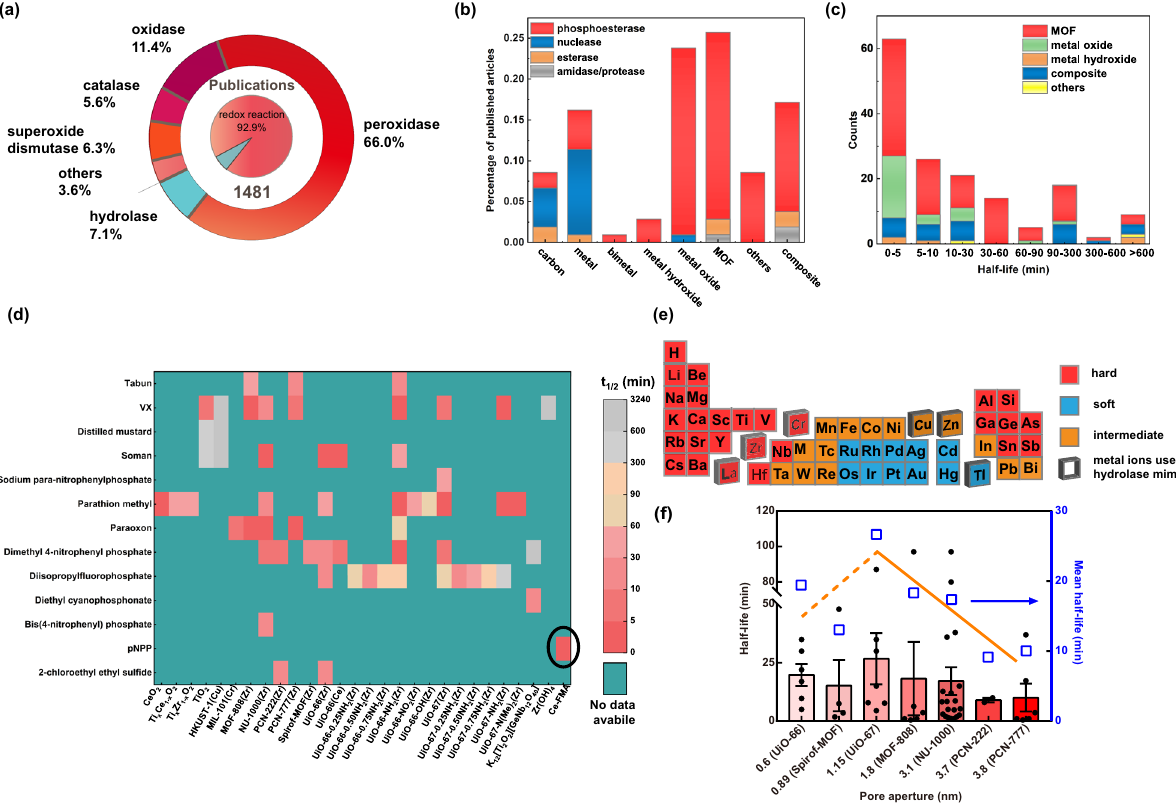
Fig. 1 The overall statistical analysis of hydrolytic nanozymes. a Proportions of different types of nanozymes. Raw data were adapted from Wu et al. 3 . b Stacked histogram of the publication frequency distribution of studies on different types of material related to each type of hydrolase. c Stacked histogram of the number distribution of each material based on its half-life of phosphatase-like activity. d Heat map of the half-lives of various phosphatase-like nanozymes and their corresponding substrates. Each half-life is presented as the mean unless there is only one sample. The circled one represents the data-informed Ce-FMA in this work. e Periodic table of metal elements mapped by hard-soft-acid-base theory. The red indicates hard Lewis acid, the blue indicates soft Lewis acid and the yellow indicates the intermediate Lewis acid. Titled squares represent metal compositions that have been reported with hydrolase-like activity. f Half-lives of reported Zr-based MOFs versus their pore aperture; the mean values are shown as blue empty squares. The number associated with each MOF on the x-axis represents the pore/window aperture 14,40,47 – 51 . Each half-life is presented as the mean±standard